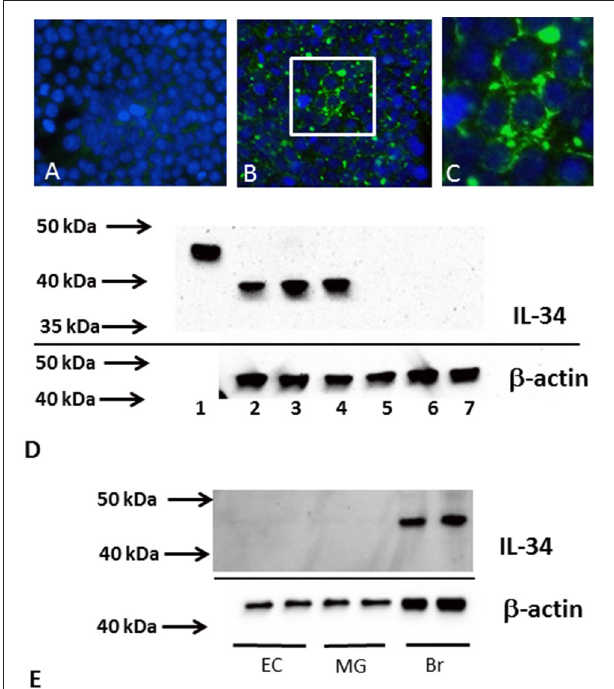
FIGURE 2 | IL-34 antibody validation. Results shown employed a rabbit polyclonal to IL-34 (Abcam no. AB74548). Similar results were obtained using mouse monoclonal to IL-34 (AB101443) and sheep polyclonal to IL-34 (R and D Systems, AF5265). (A–C) Immunocytochemistry staining of HEK cells transfected with control plasmid (GFP) (A) or plasmid coding IL-34 (B,C) . Specific immunostaining (green) was only detected with IL-34 plasmid. Cells were counterstained with DAPI (blue). Low magnification (B) and higher magnification (C) . (D) Western blot showing detected bands using AB74548 antibody on recombinant IL-34 (lane 1), and different IL-34 transfected HEK cell samples (lanes 2–4), and different GFP plasmid transfected HEK cell samples (lanes 5–7). The cell expressed IL-34 had molecular weight of approximately 39 kDa. (E) Western blot showing a single band (45